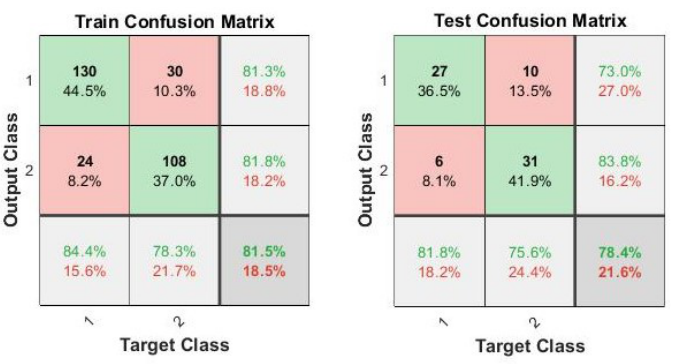
Figure 8. Confusion matrix of the dead-cocoon selection procedure based on the logistic regression model from the photodiode matrix (Class 1 stands for dead cocoons; Class 2 stands for alive